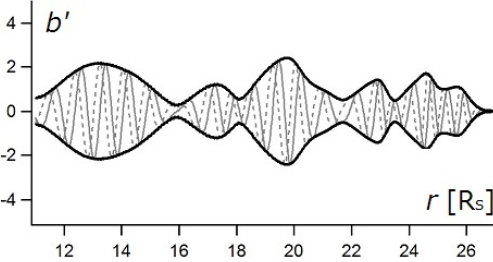
Fig. 1. The transverse magnetic field ( b 0 dashed lines), ±| b 0 | (black bold lines) at t = 11 (1 . 5 × 10 4 [s])).